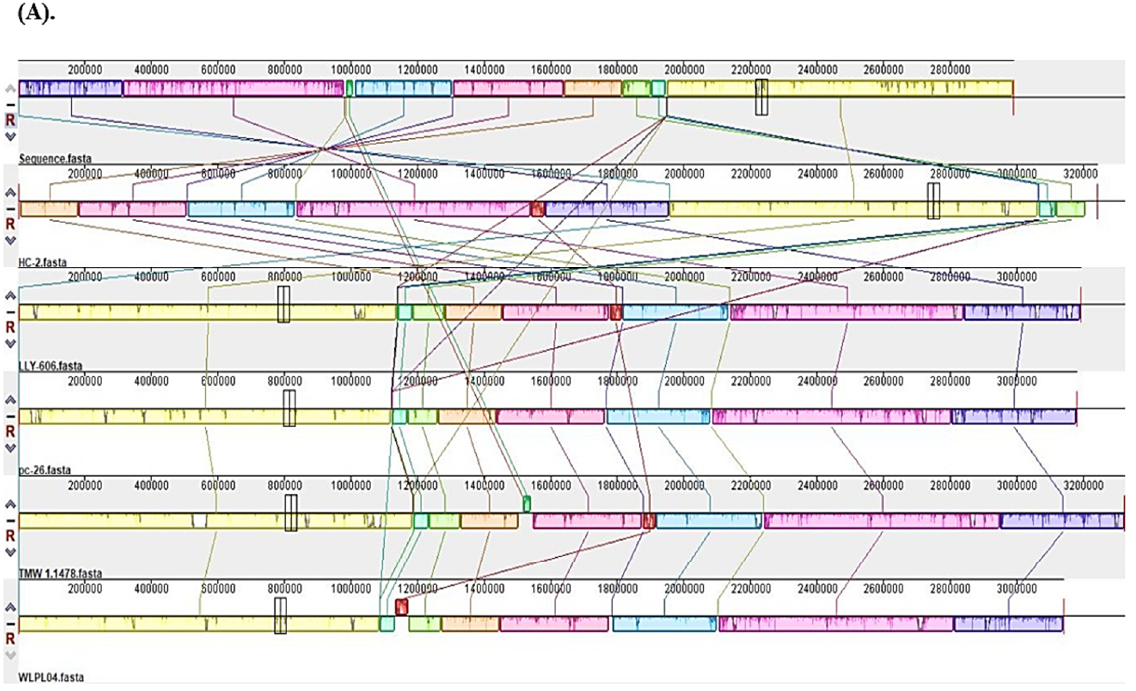
Figure 8. ( A ) Collinearity relationship of Lp YW11 with HC-2, LLY-606, pc-26, TMW, and WLPL04 showing aligned EPS-producing genes (Pink), transporter genes (Blue), regulatory genes (Green). ( B ) Phylogenetic Analysis of Lp YW11 with HC-2, LLY-606, pc-26, TMW and WLPL04. 2.8. Molecular Modelling With a QMEAN Z-Score of 0.724, 0.785, 0.760, and 0.876 independently, the trRosetta predicted the tertiary design of cdt, spvB, stxB, and ymt with 81%, 96%, 81%, and 9% grouping personalities. The protein structure had a higher certainty expectation, as shown